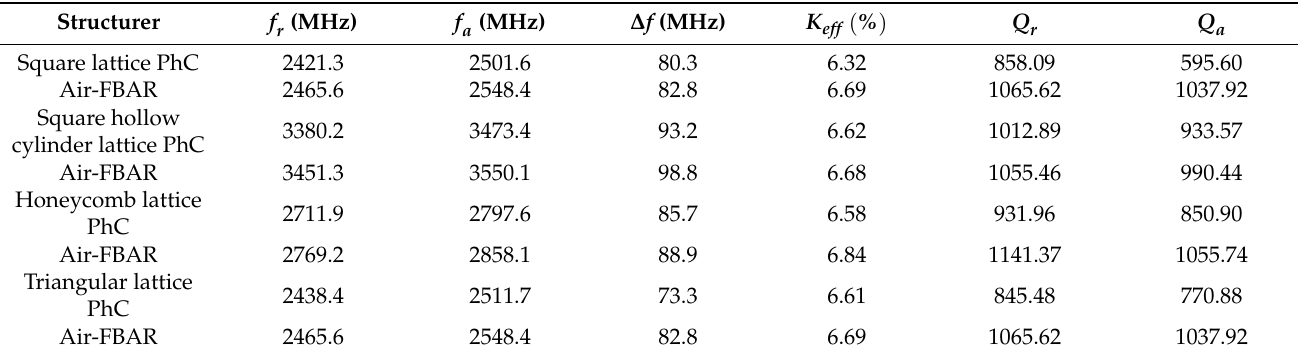
Table 2. Performance summary for four different structures of PhC-FBARs, and comparison with traditional Air-FBARs. Structurer